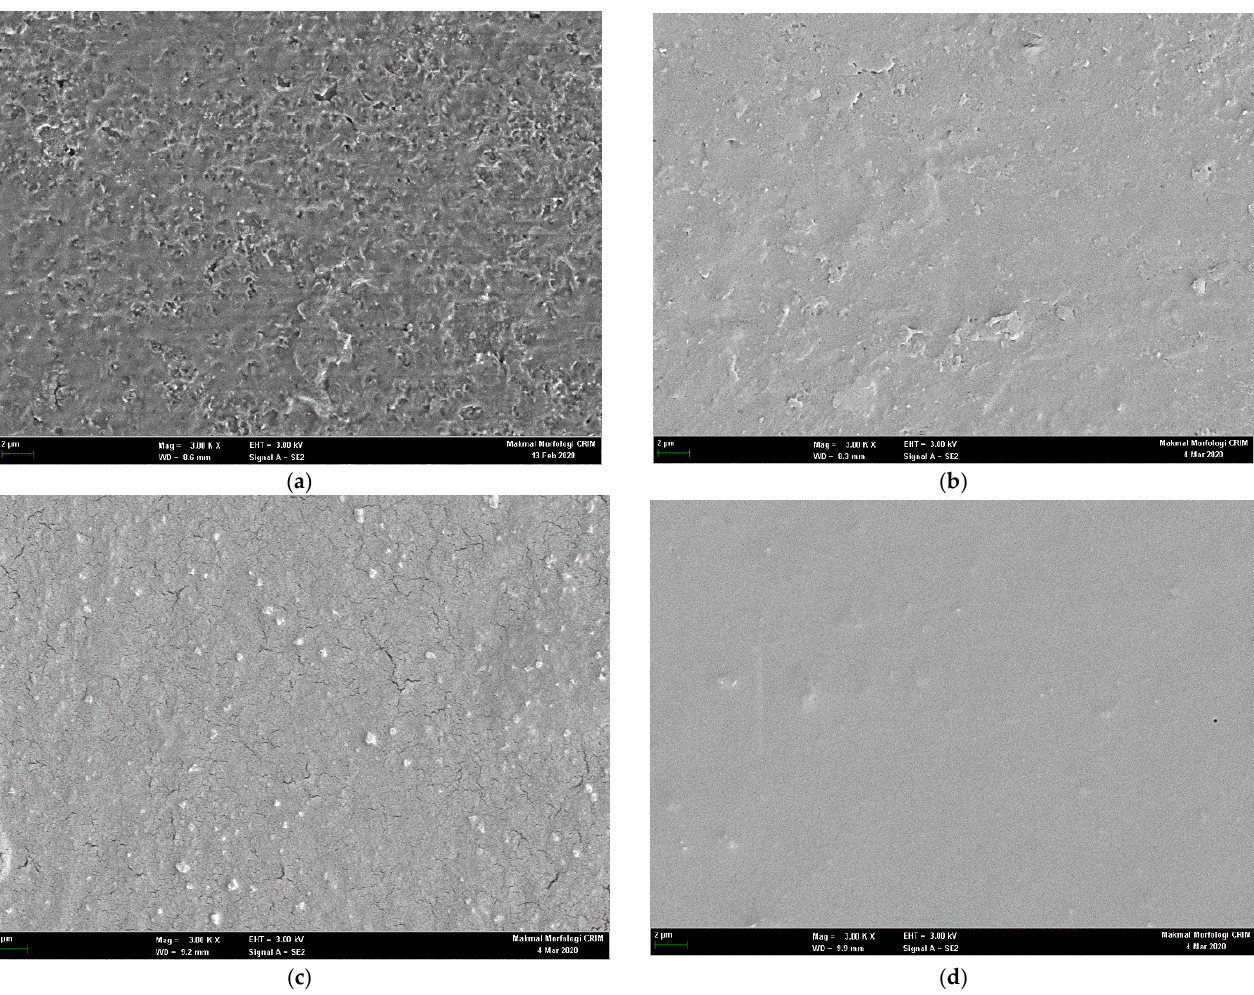
Figure 5. Scanning electron micrographs of ( a ) untreated, ( b ) 1 min, ( c ) 3 min, and ( d ) 5 min microwave treated pectin and sodium alginate blend film.